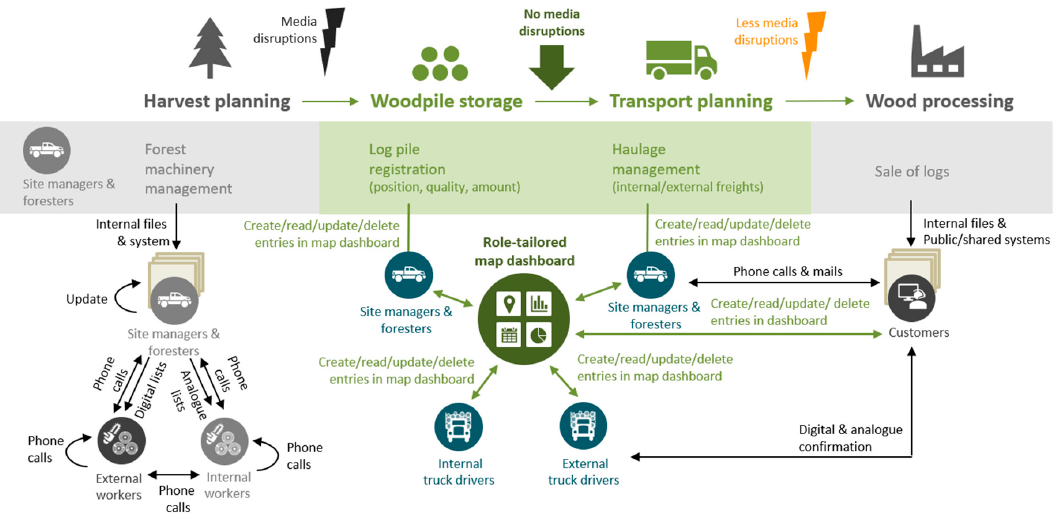
Figure 12. Reduction of media disruptions within the FbSC processes by using the role-tailored map dashboard prototype (then). 609